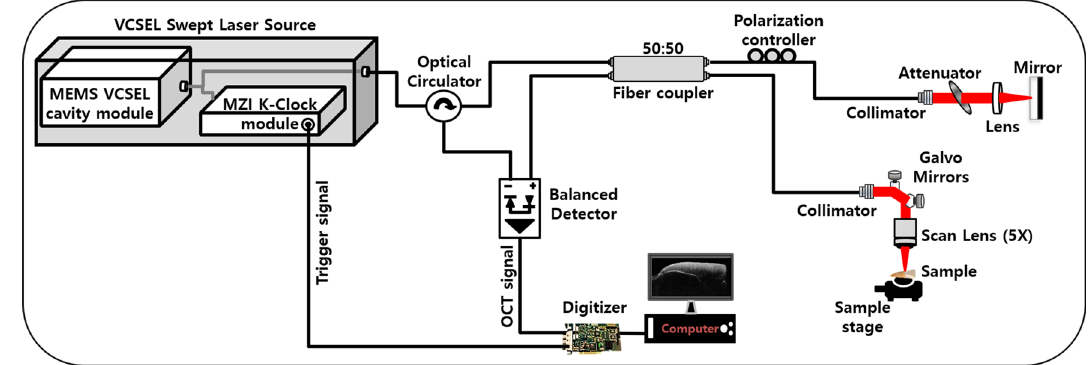
Figure 1. Schematic representation of the swept-source optical coherence tomography (SS-OCT)